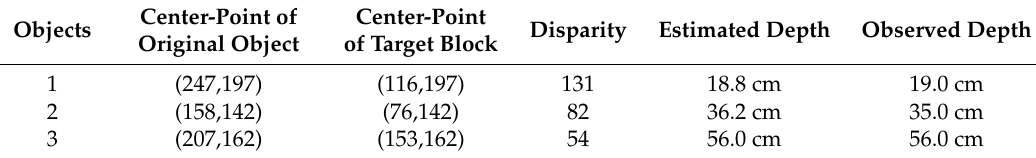
( b ) Figure 18. Hardware configuration of the embedded stereo vision system. ( a ) System hardware architecture. ( b ) Photo of the system. 3.2.1. System Performance Analysis A sample image was used to verify the performance of the proposed stereo vision system (Figure 19). Figure 19a,b are the left and right images captured by the dual camera vision module, respectively. Figure 19c,d present the results of object segmentation and CCL processing using the left image, respectively, and Figure 19e shows the results of the image after stereo matching and depth estimation were conducted. The image in Figure 19e confirms that the proposed system can accurately generate depth maps by utilizing left and right images.